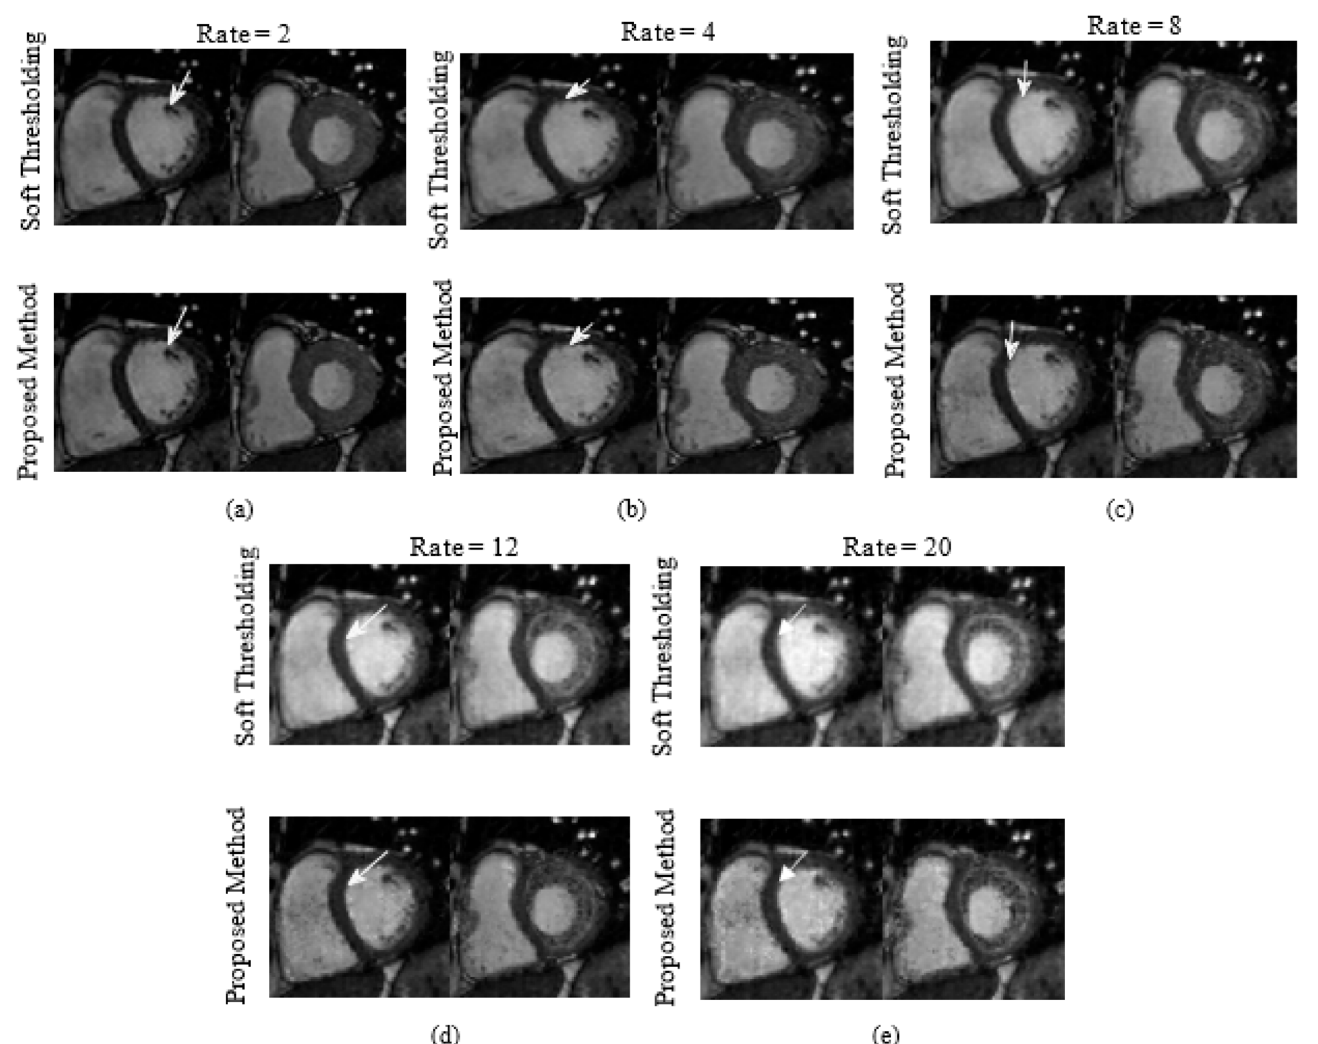
Figure 16. In real vivo data ( a ) Compares proposed method at bottom row with IST at top row with acceleration rate of 2. The arrow in ( a ) shows very minute artifacts. ( b ) depicts the performance of proposed method at acceleration rate equal to 4. The arrow in ( b ) depicts the presence of arte- facts ( c ) shows the results of both algorithms with acceleration rate set at 8. The artefacts due to subsampling become gradually more visible in IST results as highlighted by arrow mark ( d ) depicts the results when acceleration rate is set at 12. Both techniques depicts the artefacts, however these artefacts are visible in the IST as mentioned by the white arrow in the figure ( e ) show very much degraded image quality of IST, while comparing it with the proposed method. The subsampling artefacts dominate the traditional IST result when acceleration rate R is set at